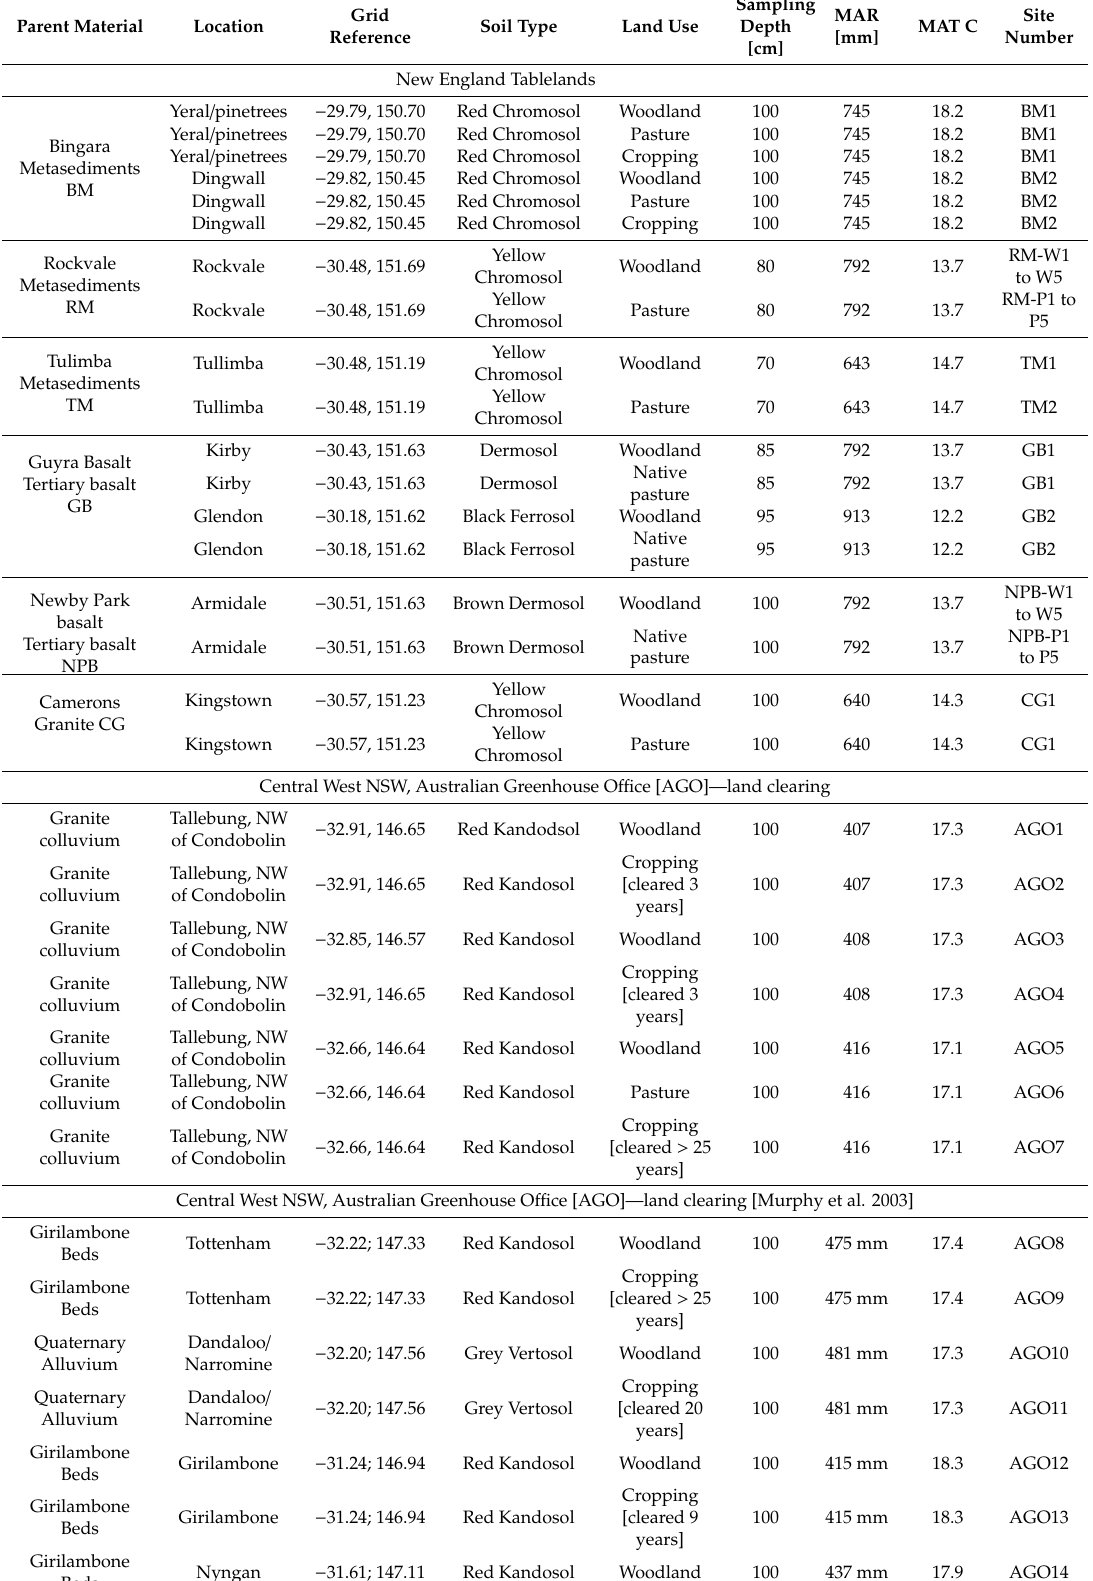
Table 2. Site details. GO is Australian Greenhouse O ffi ce set of profiles. LR is Little River set of profiles. MAR is mean annual rainfall. MAT is mean annual